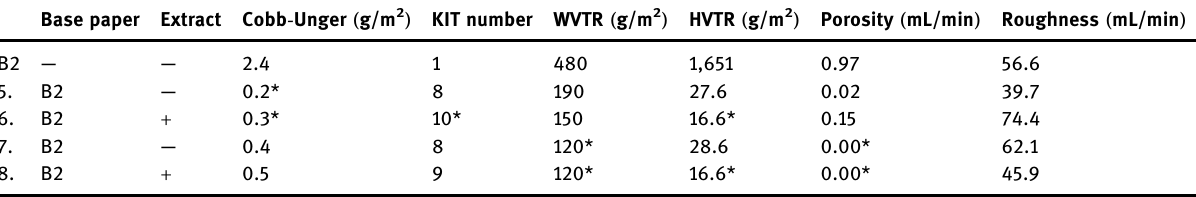
Table 3: Basic and barrier properties of papers tested with base paper